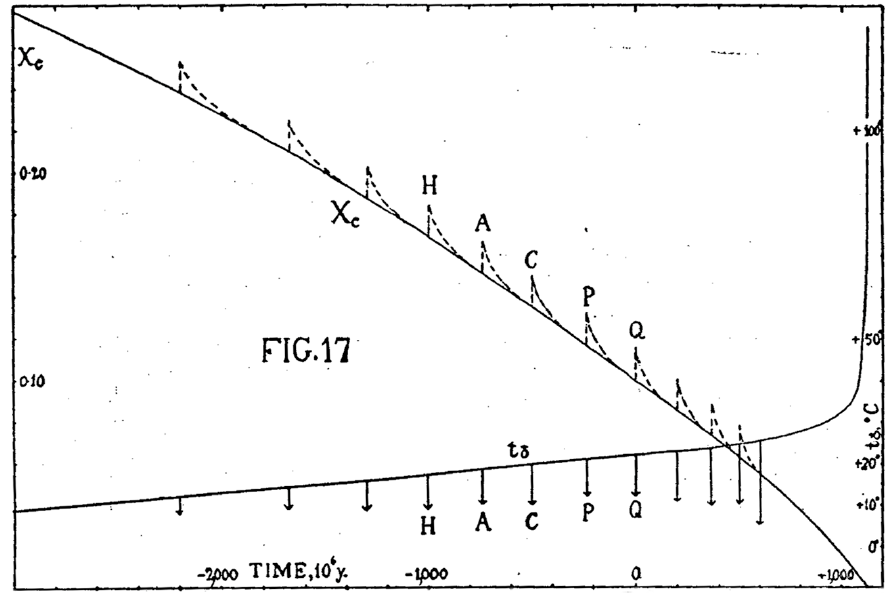
Fig. 5. Sample variation of central hydrogen content of the Sun ( X c ) and of mean temperature of the Earth ( t ♁ ) with time. Scale of x -axis is millions of years from our era. Based on ¨Opik